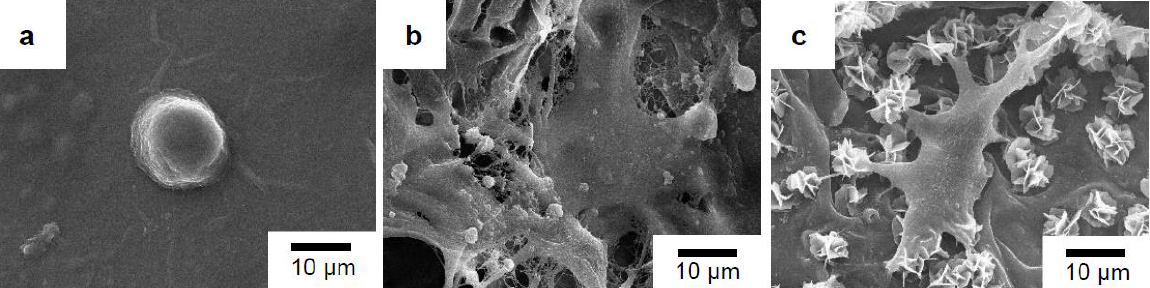
Figure 12. SEM images of MG-63 cell morphology after 3 days of incubation on glass slide as the control ( a ), the pristine PLA/PBAT scaffold ( b ), and the PLA/PBAT scaffold with PDA-assisted biomineralization ( c ).